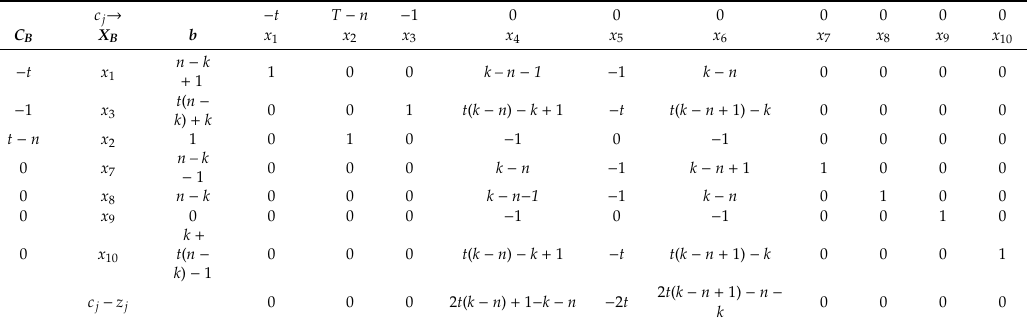
Table 3. The final simplex table of IPM I for Case